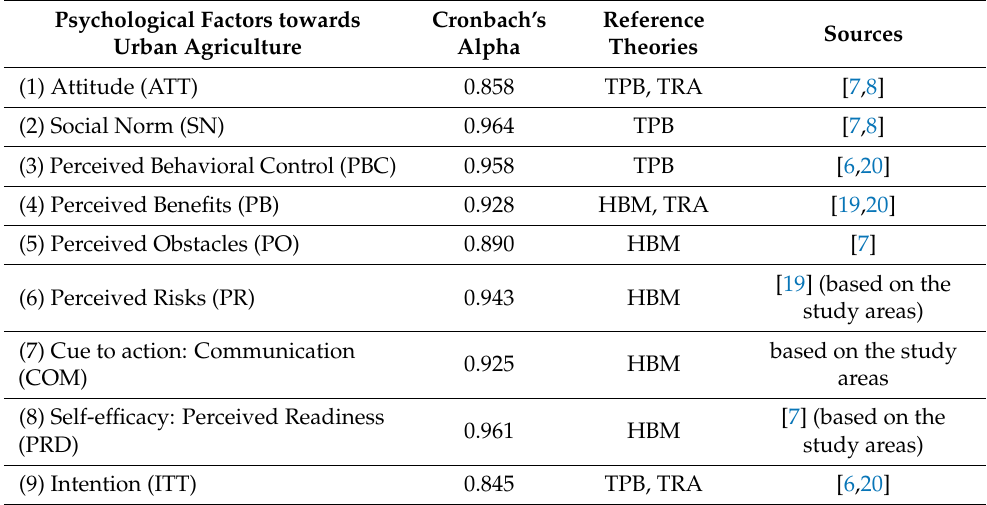
Table 1. Psychological factors affecting urban agriculture, reliability test, and reference theories.